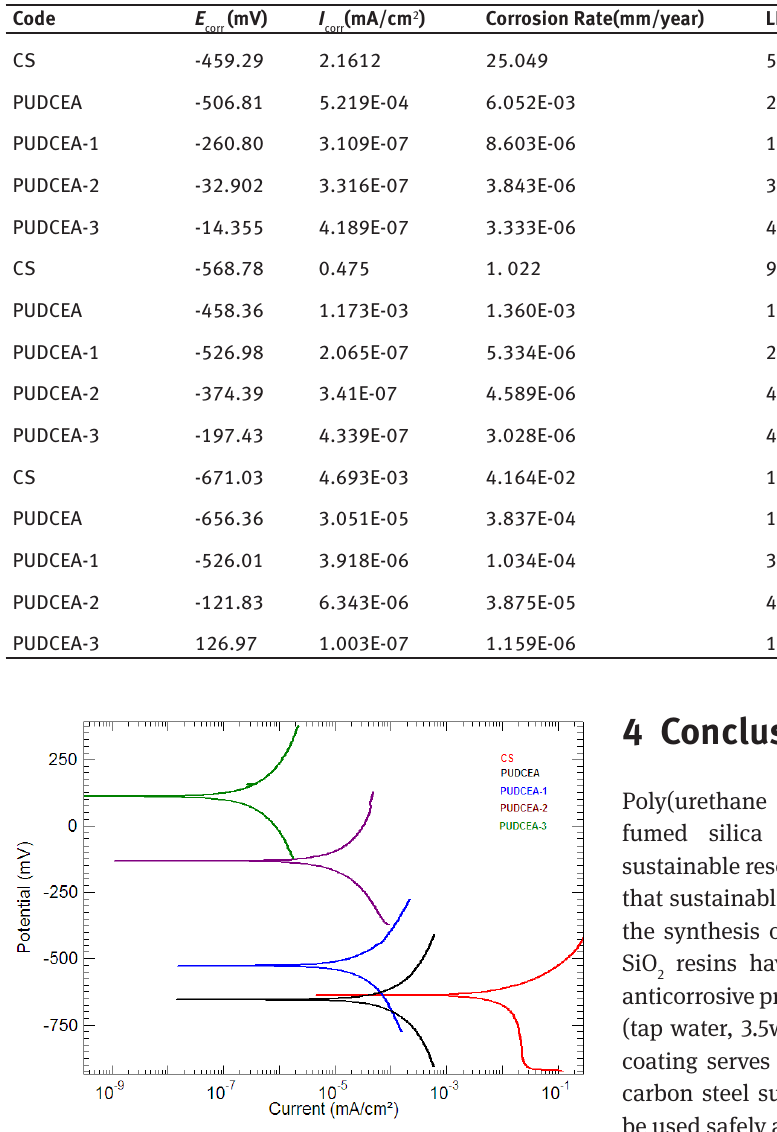
Table 1: Corrosion parameters for carbon steel (CS) and PUDCEA coated CS in various medium. Code